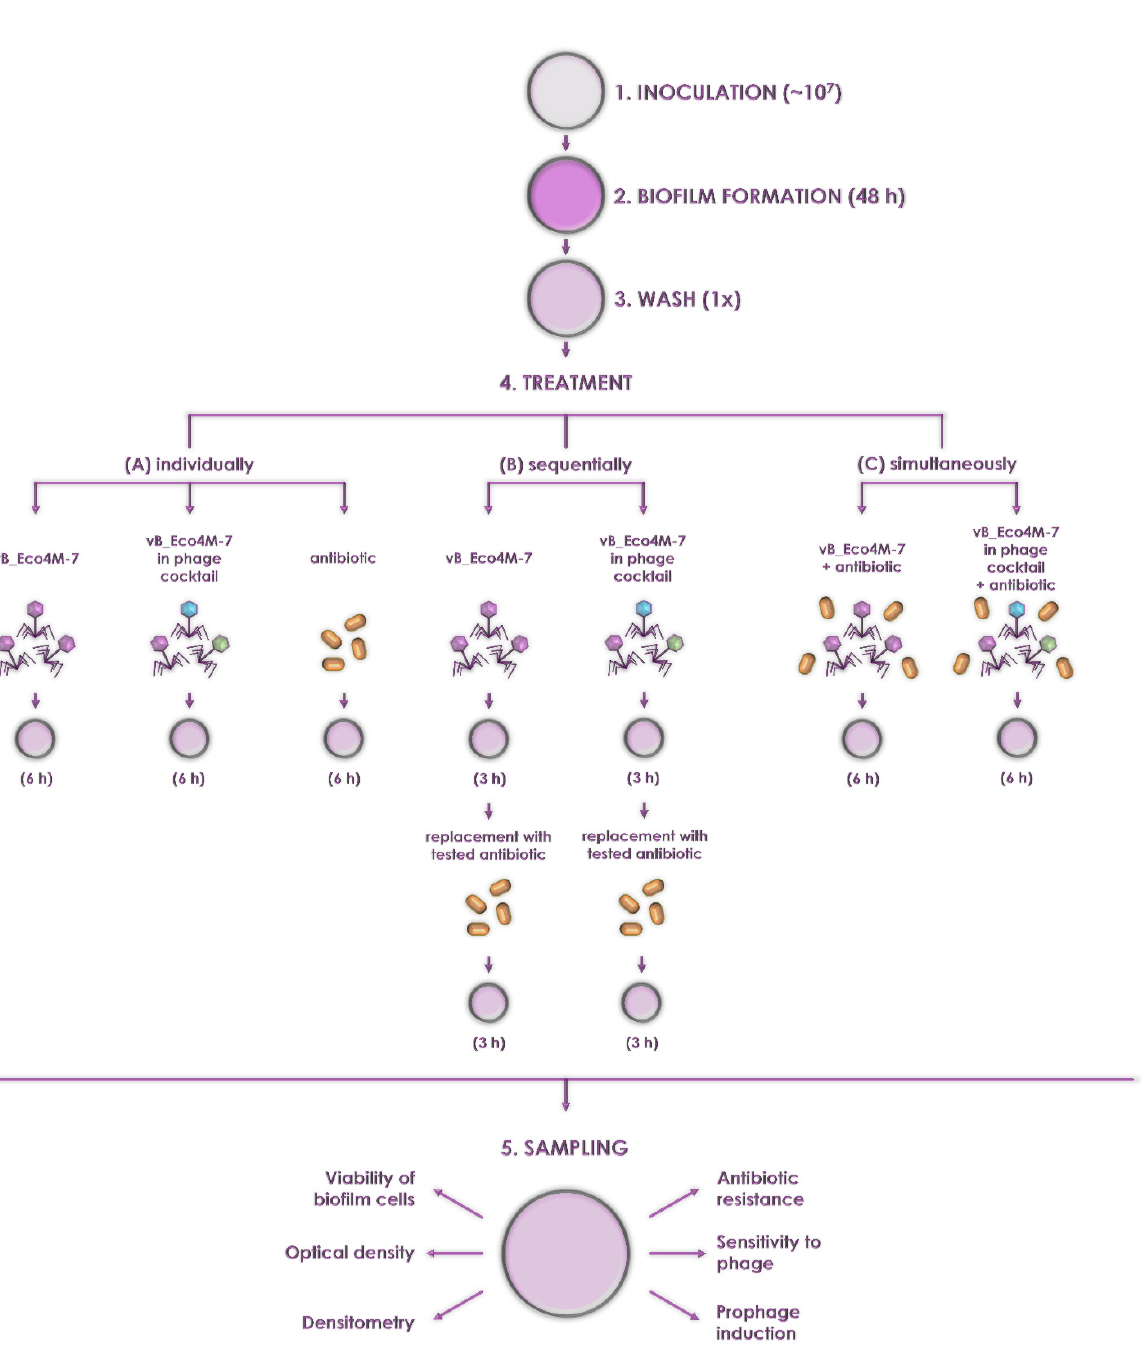
Figure 2. Schematic representation of the procedure used to assess ability of tested antimicrobial agents to eliminate E. coli O157:H7 (ST2-8624) bacteria from the biofilm. Steps 1–2 indicate the formation of the biofilm in a 12-well polystyrene plate filled with M9 medium supplemented with 0.2% glucose. Step 3 shows the removal of the planktonic cells and the rinsing of the surface-attached bacteria with PBS. Step 4 presents the eradication of bacterial biofilm with selected antimicrobial agents added individually ( A ), sequentially ( B ), or simultaneously ( C ). Step 5 depicts the analysis of the effectiveness of tested antimicrobial agents using appropriate methods.